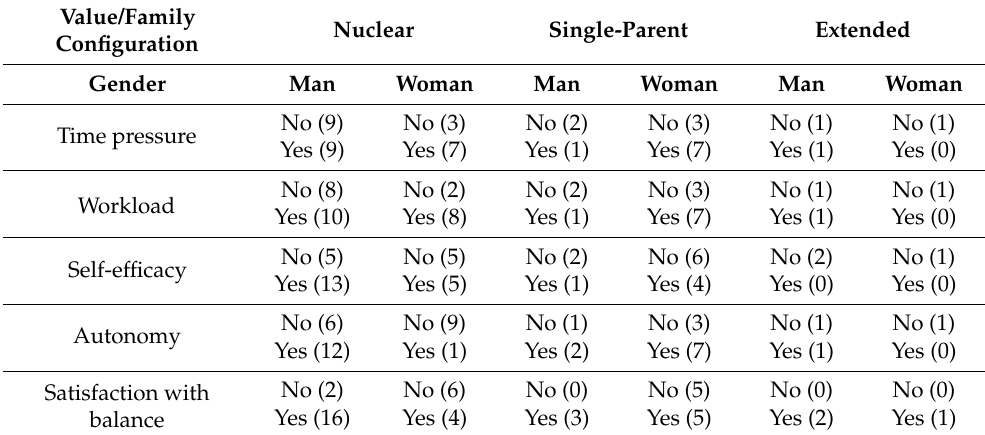
Table 1. Distribution of attributes by family configuration and